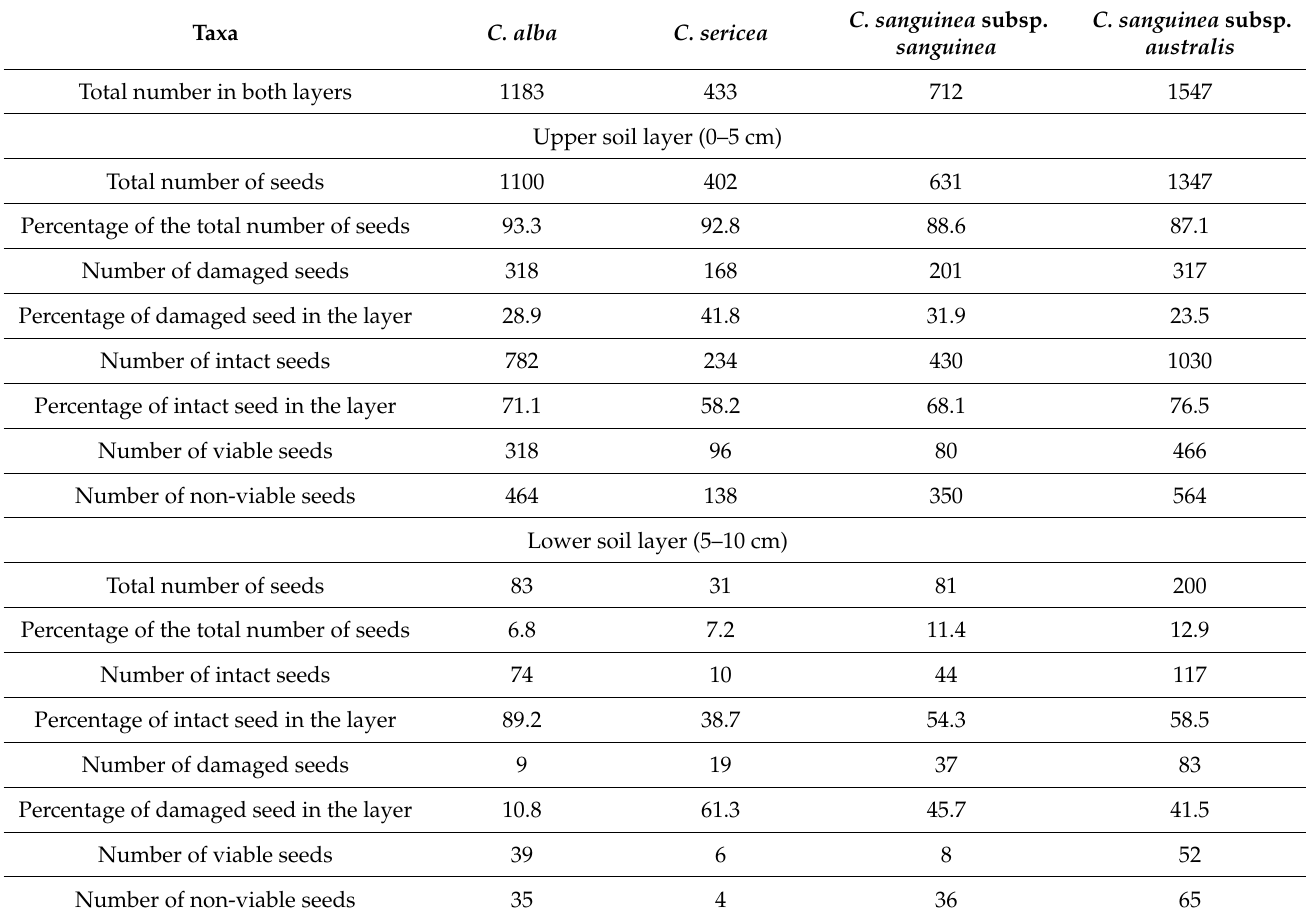
Table 2. Total number of seeds in both upper and lower soil layers, number and percentage of intact and damaged as well as viable and non-viable seeds of the studied Cornus taxa in the upper and lower soil